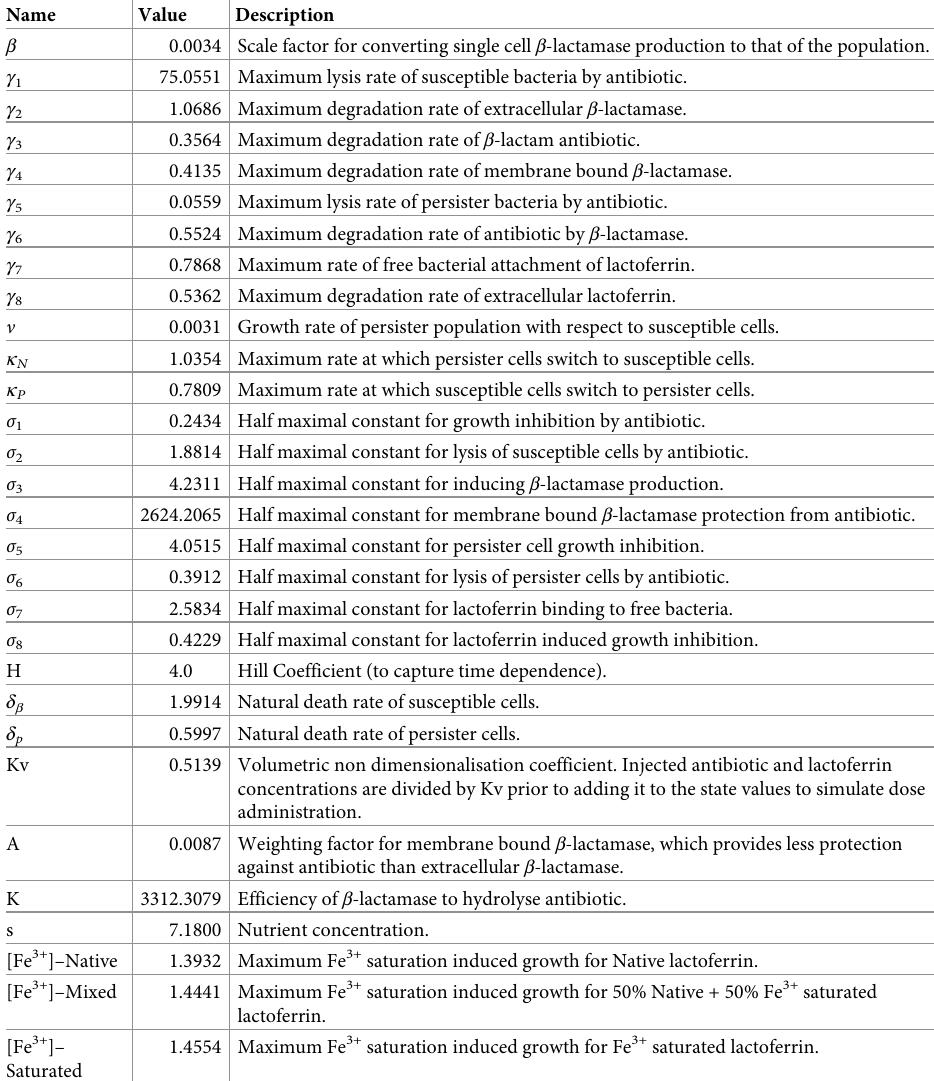
Table 1. Non dimensionalised model